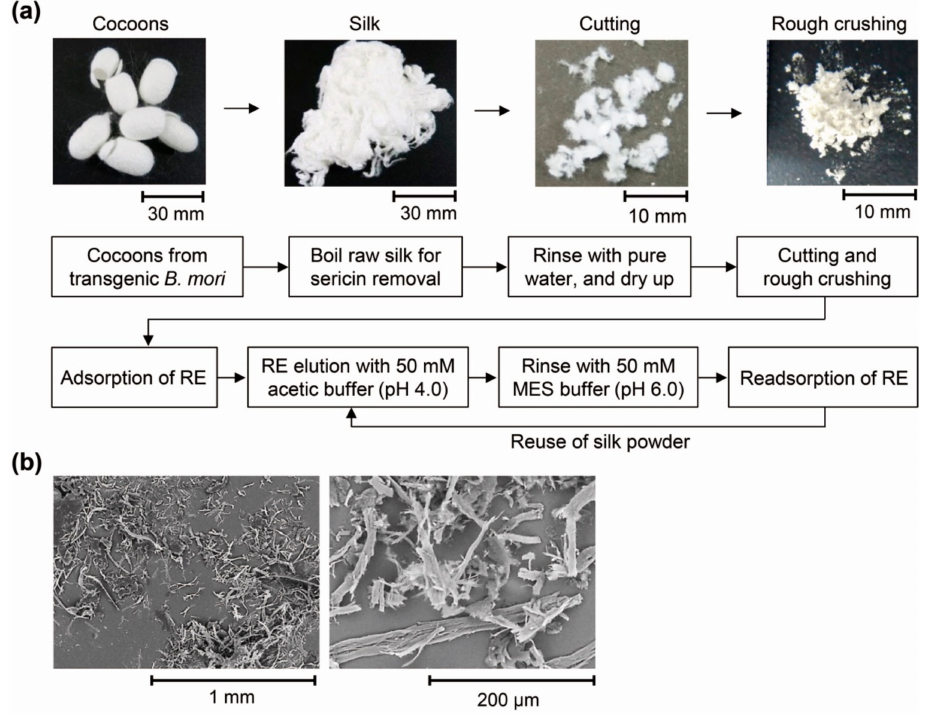
Figure 5. RE recovery process with silk powder: ( a ) Schematic diagram of the process for RE-recovery, and optical image of the prepared silk and ( b ) SEM image of roughly crushed